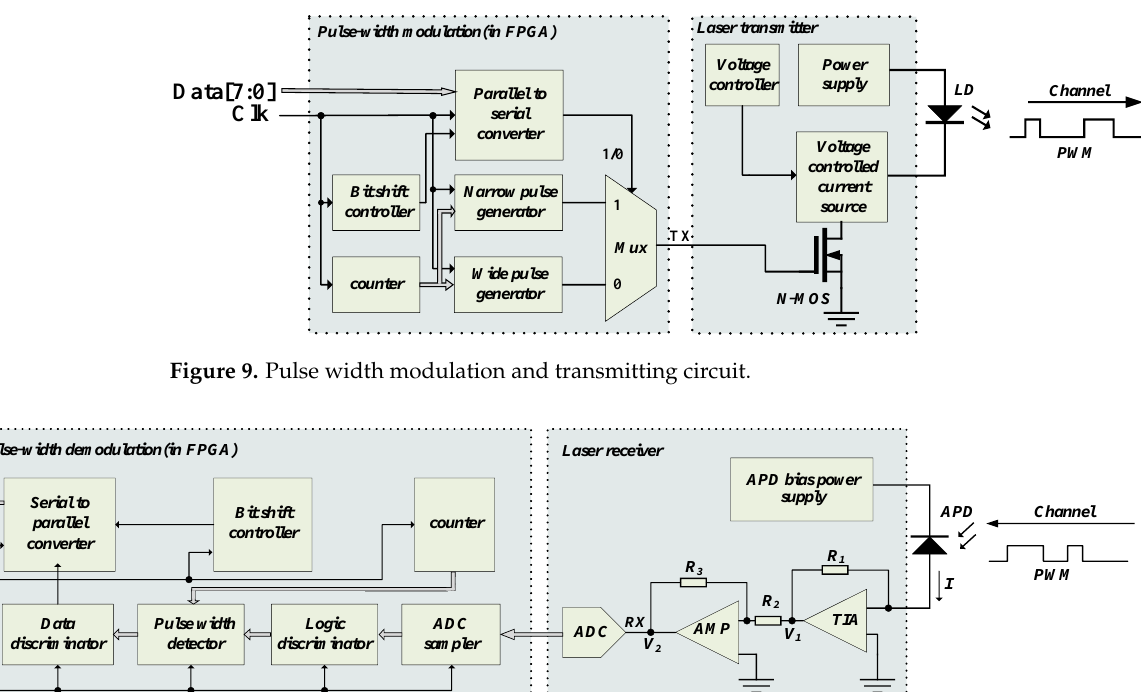
Figure 9. Pulse width modulation and transmitting circuit.